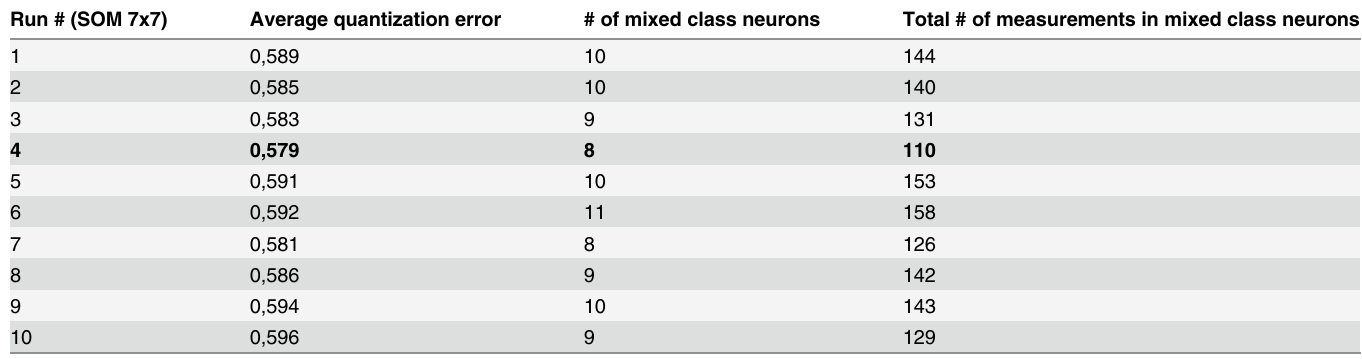
Table 2. Features of different SOM runs for the four classes of control